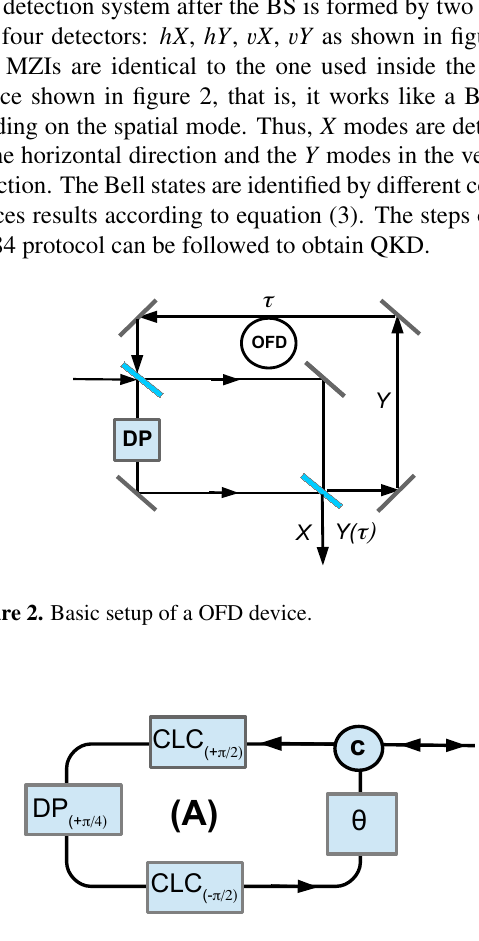
Figure 3. Basic setup of the autocompensating